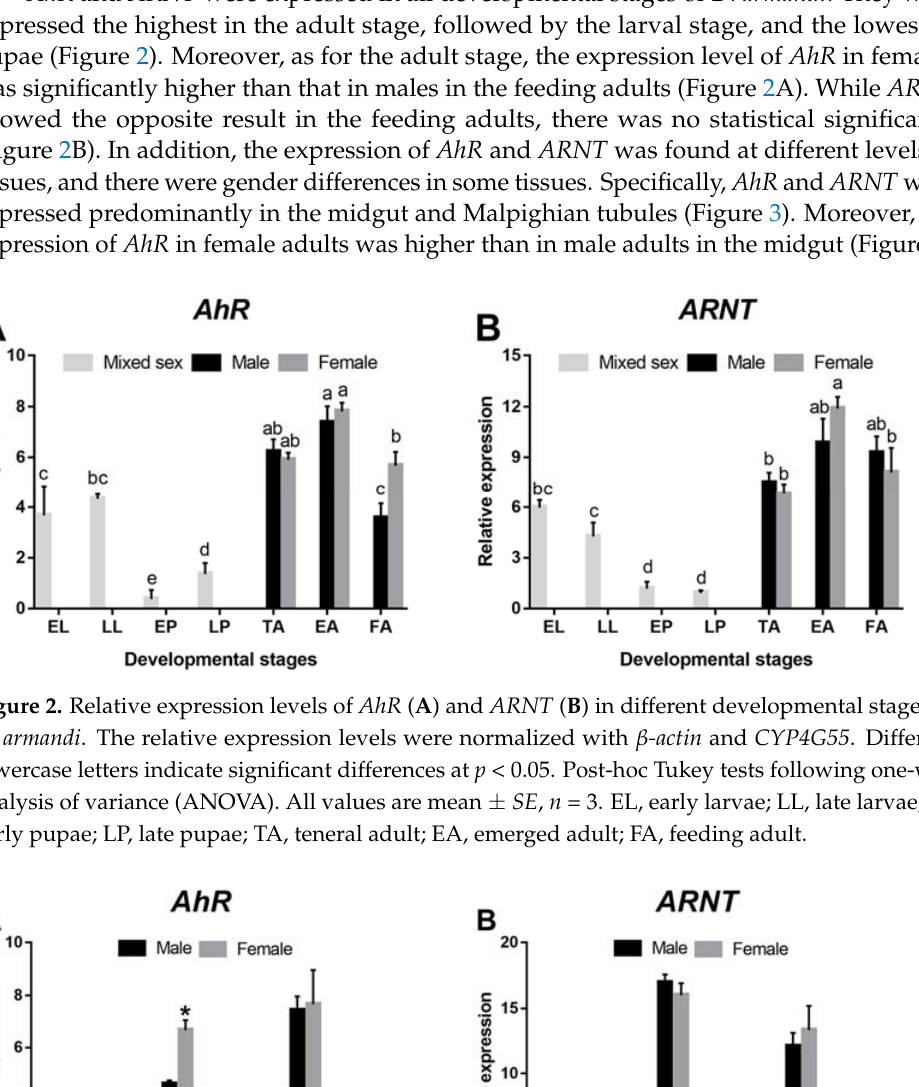
Figure 1. Phylogenetic analysis of D. armandi AhR ( A ) and ARNT ( B ) with other insect species. The phylogenetic tree was constructed in MEGA 6.0 using the neighbor ‐ joining method. Bootstrap val ‐ ues (1000 replicates) are indicated next to the branches, and GenBank accession numbers are shown in parentheses. The black dot indicates D. armandi AhR and ARNT.